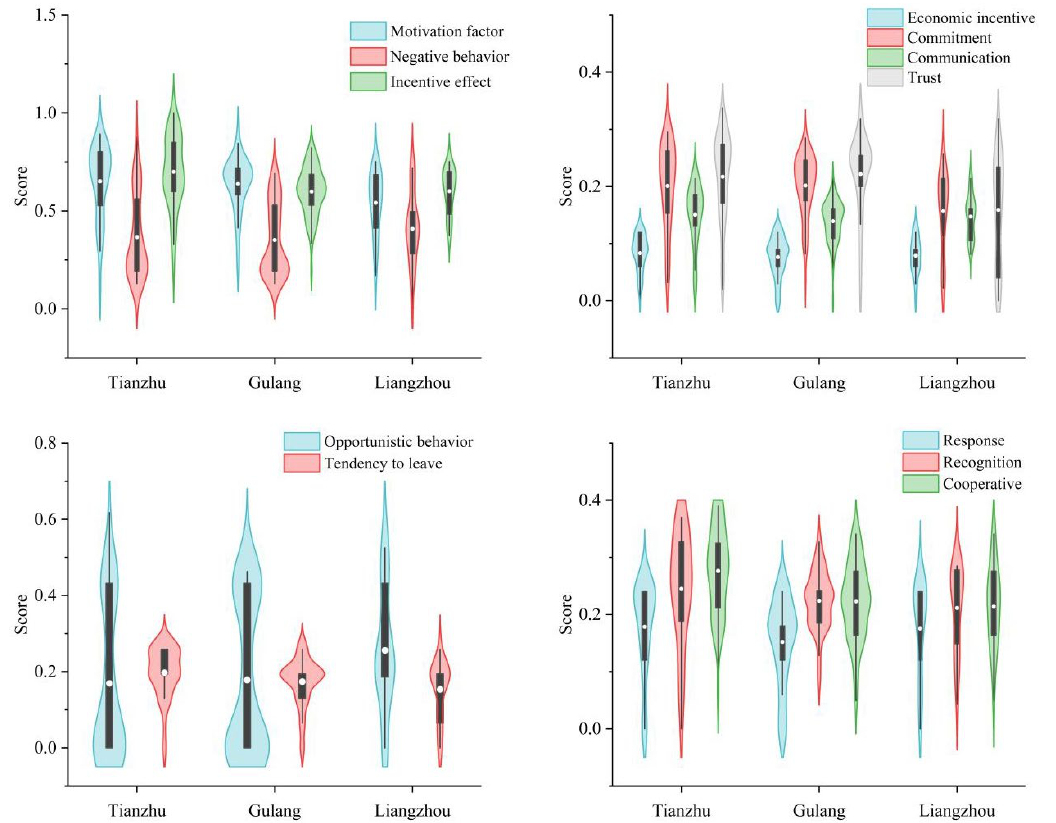
Figure 5. The scores of motivation factor, negative behavior and incentive effect for migrants in different regions.